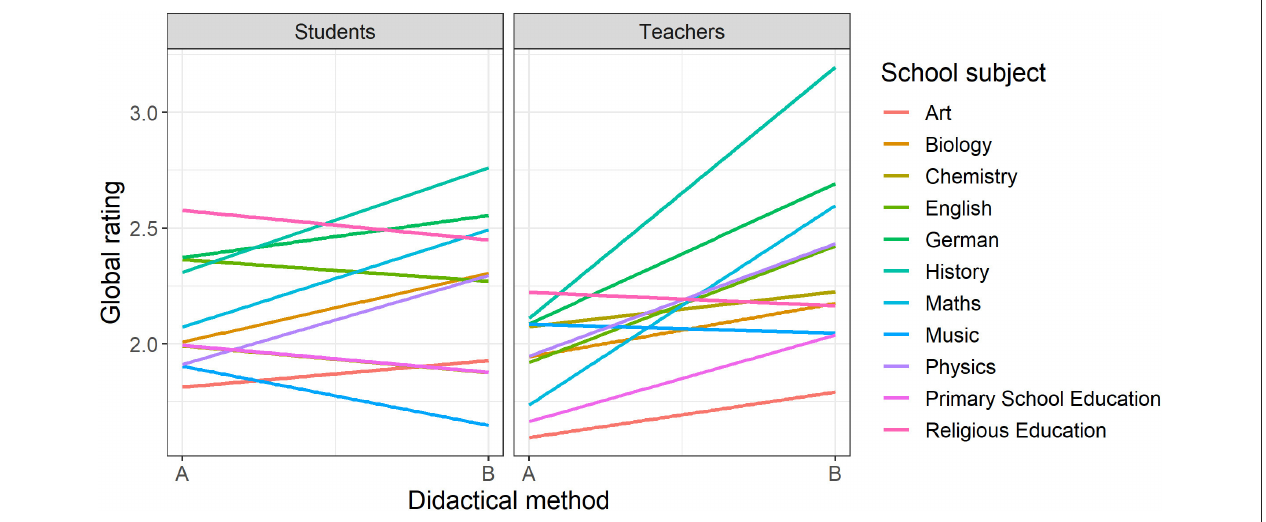
a video pair (A: 0 vs. B: 1) as well as the variable for group TABLE 3 | Linear mixed model with the dependent variable global rating for